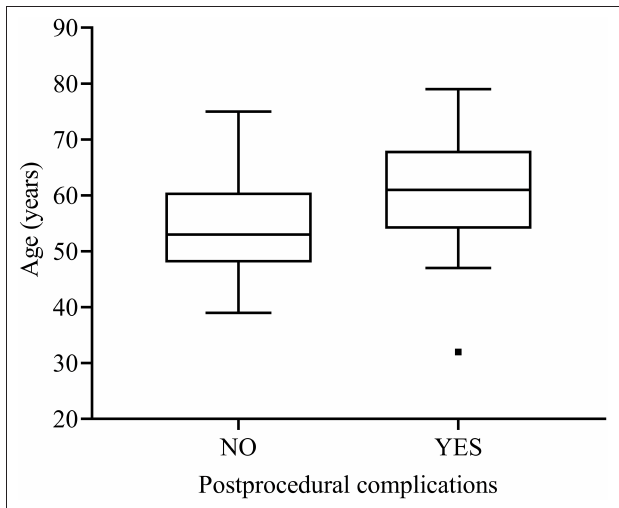
FIGURE 2 | Box plot for age and postprocedural complications.